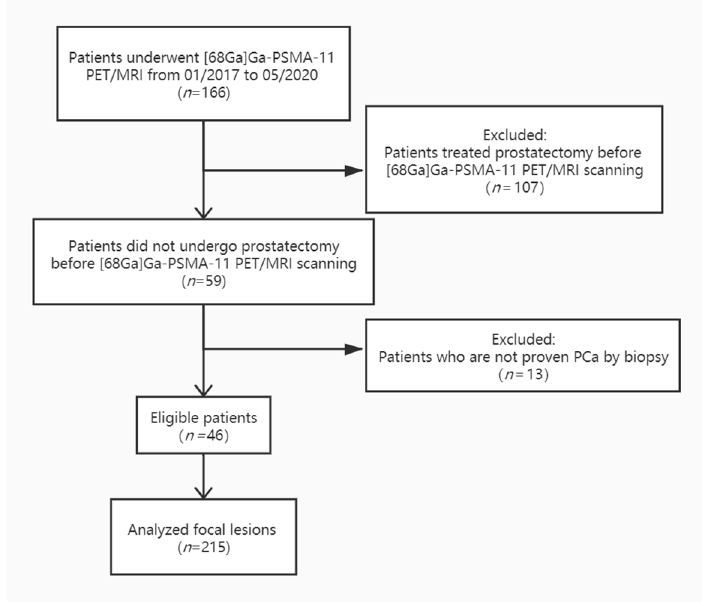
Figure 4. [ 68 Ga]Ga-PSMA-11 PET: gallium 68–labeled prostate-specific membrane antigen PET, mpMRI: multiparametric